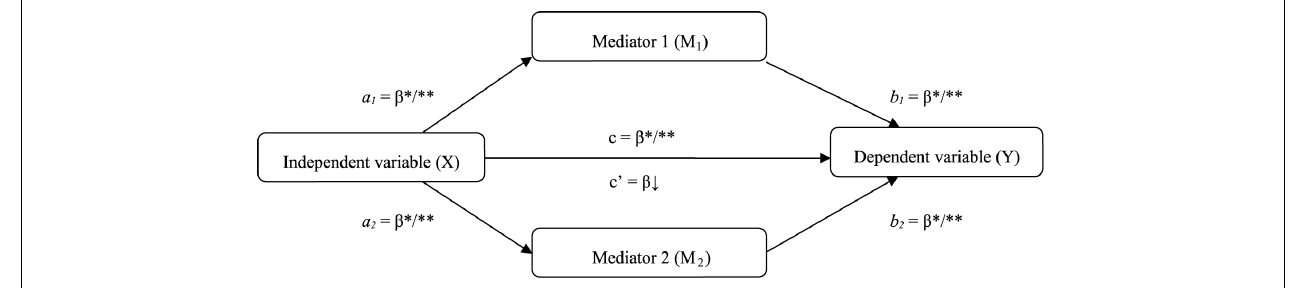
FIGURE 1 | Theoretical model of the role of meaning in life, and the relationship between acceptance of illness and well-being. ∗ p < 0.05; ∗∗ p < 0.01.